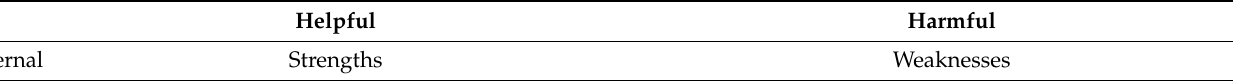
Table 6. SWOT analysis of biogas and biohydrogen production from seaweed